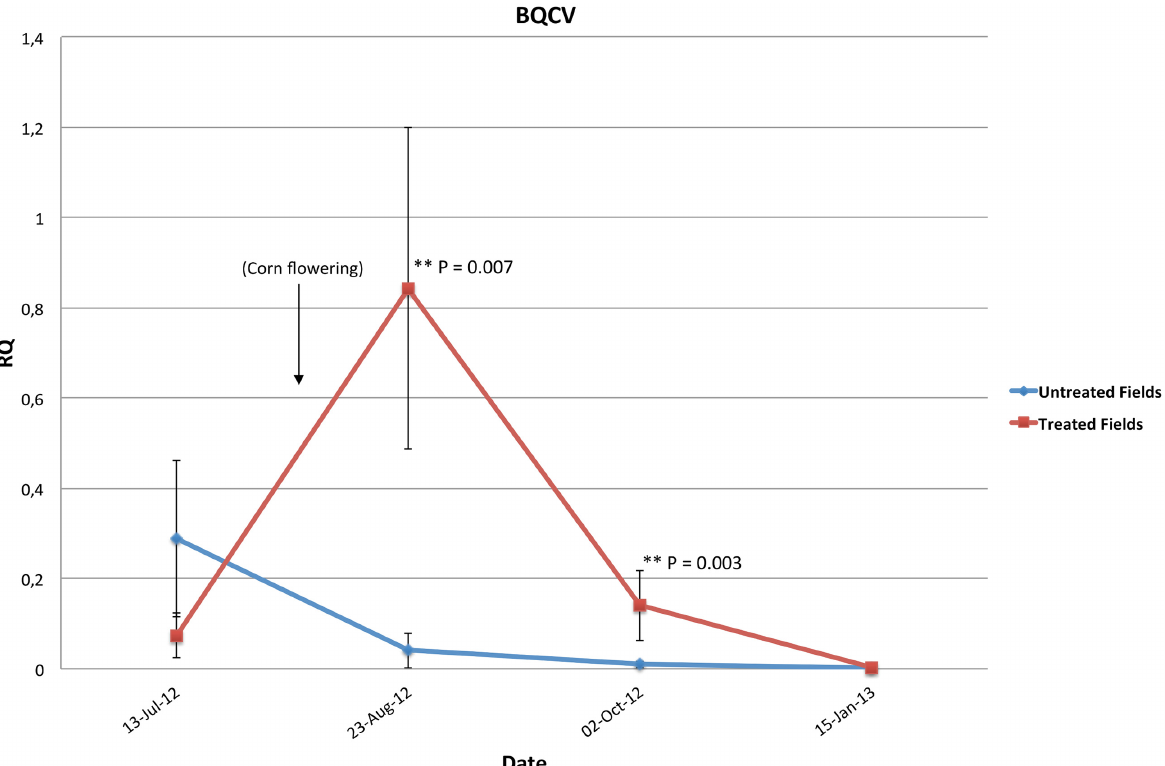
Fig 3. Mean level of the black queen cell virus (BQCV) infection for the 32 studied colonies, 16 colonies in each treated and untreated fields on four different dates. RQ is the relative quantity of the virus infection in the original samples. Error bars are the Standard Errors (SE) of each studied group. P values is ** P <